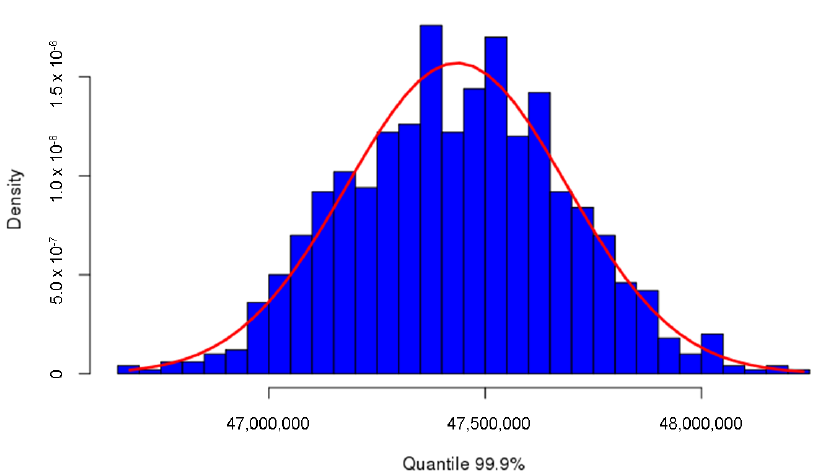
Figure 4. Histogram of 99.9% quantiles derived from 1000 Monte Carlo repetitions, compared with the estimated normal